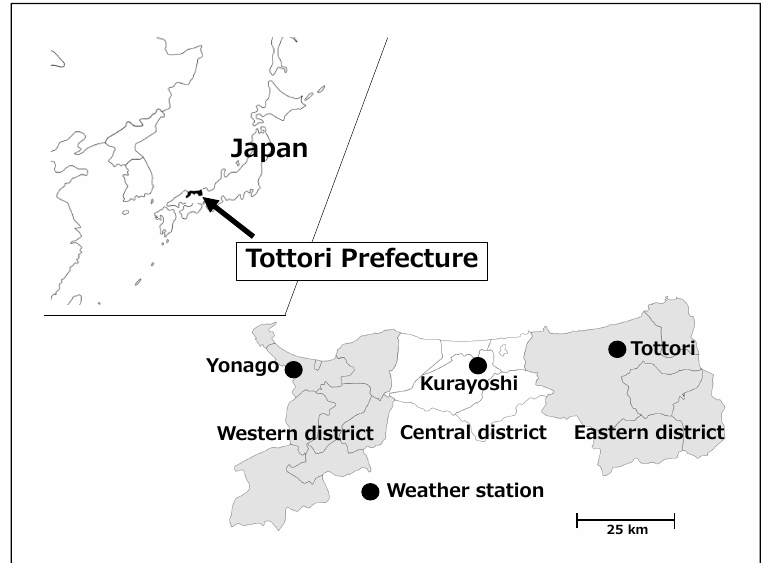
Figure 1. Location of the Tottori Prefecture and meteorological observation sites. The eastern district (right dark area) includes five, the central district (light area) includes five and the western district (left dark area) includes nine